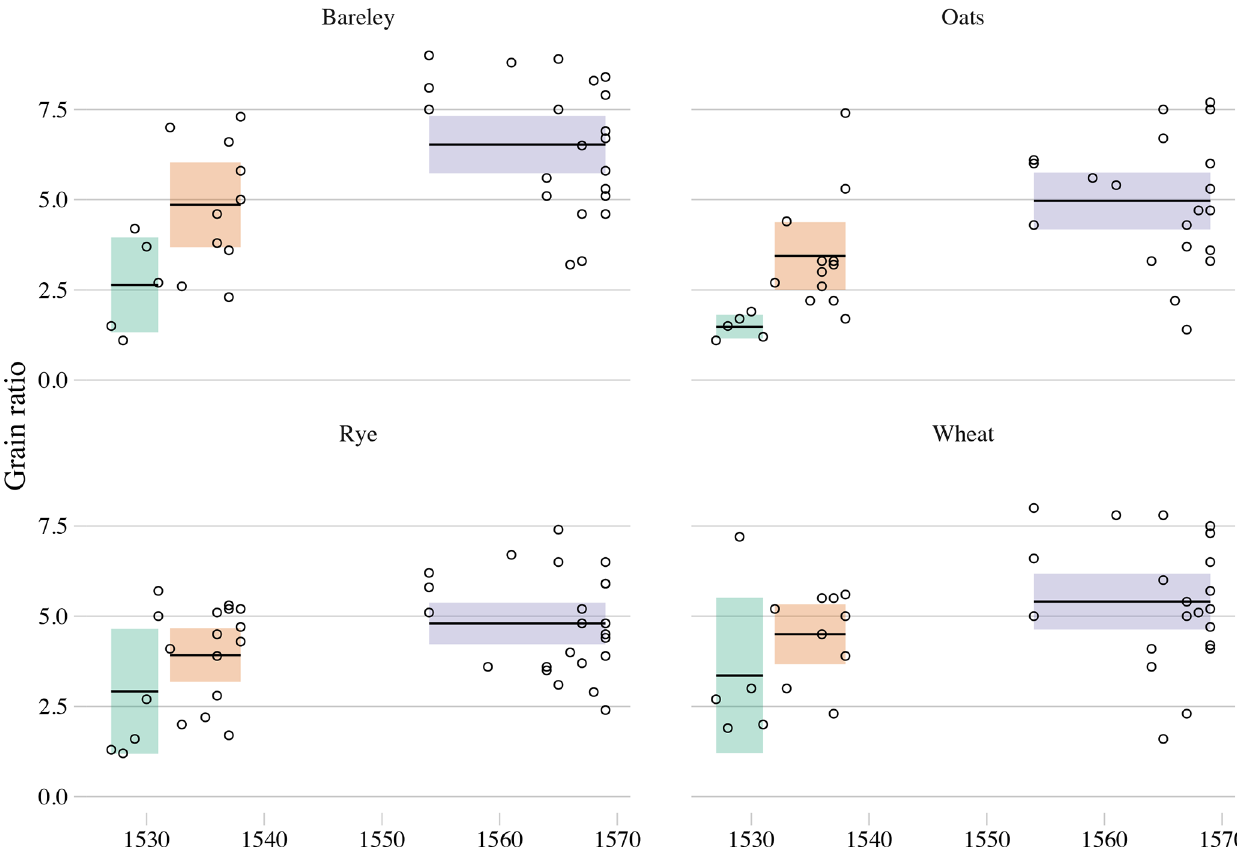
Figure 6. Grain yield ratio of main crops in the royal estates. Sources: Wawrzy´nczyk (1974).